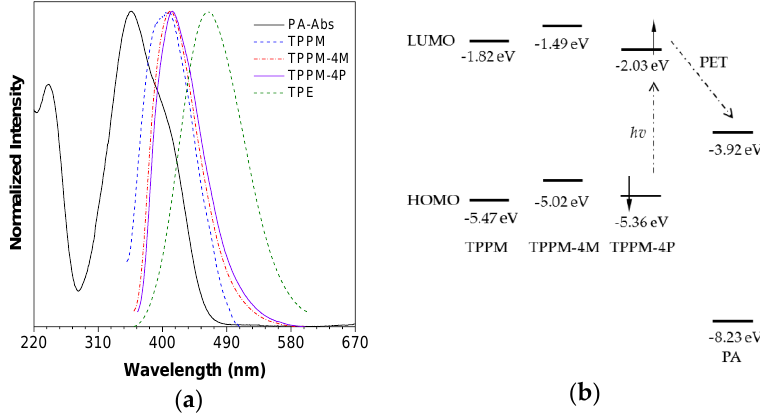
Figure 8. ( a ) Normalized UV-Vis absorption spectra of PA and PL spectra of TPPM, TPPM-4M, TPPM-4P and TPE in THF/water mixture ( f w = 99%); ( b ) Calculated energy level diagrams of TPPM derivatives and the PA.